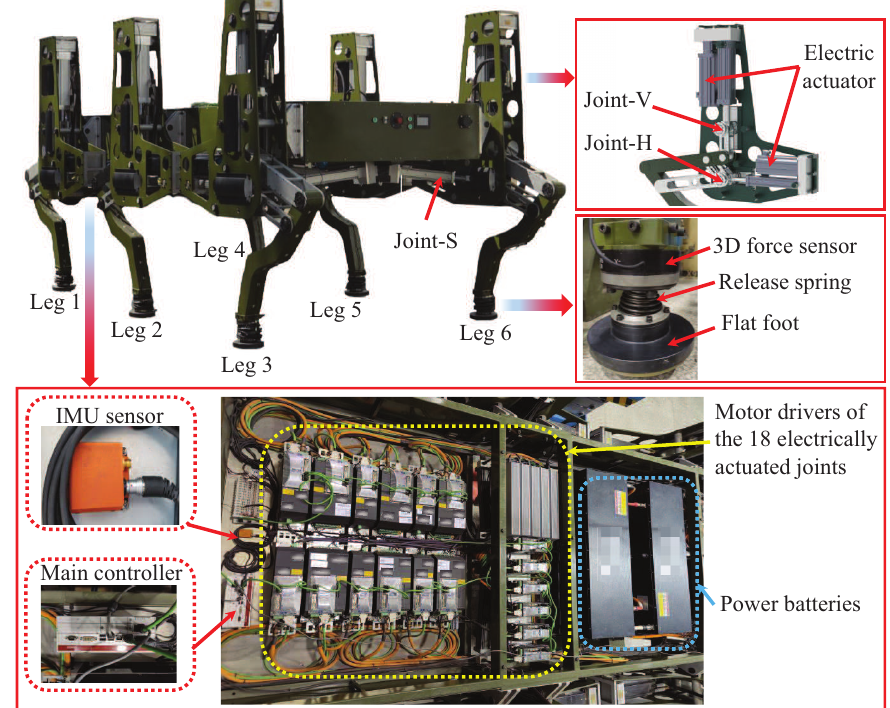
Figure 1. The overall structure of the large-size hexapod robot with eighteen electrically actuated